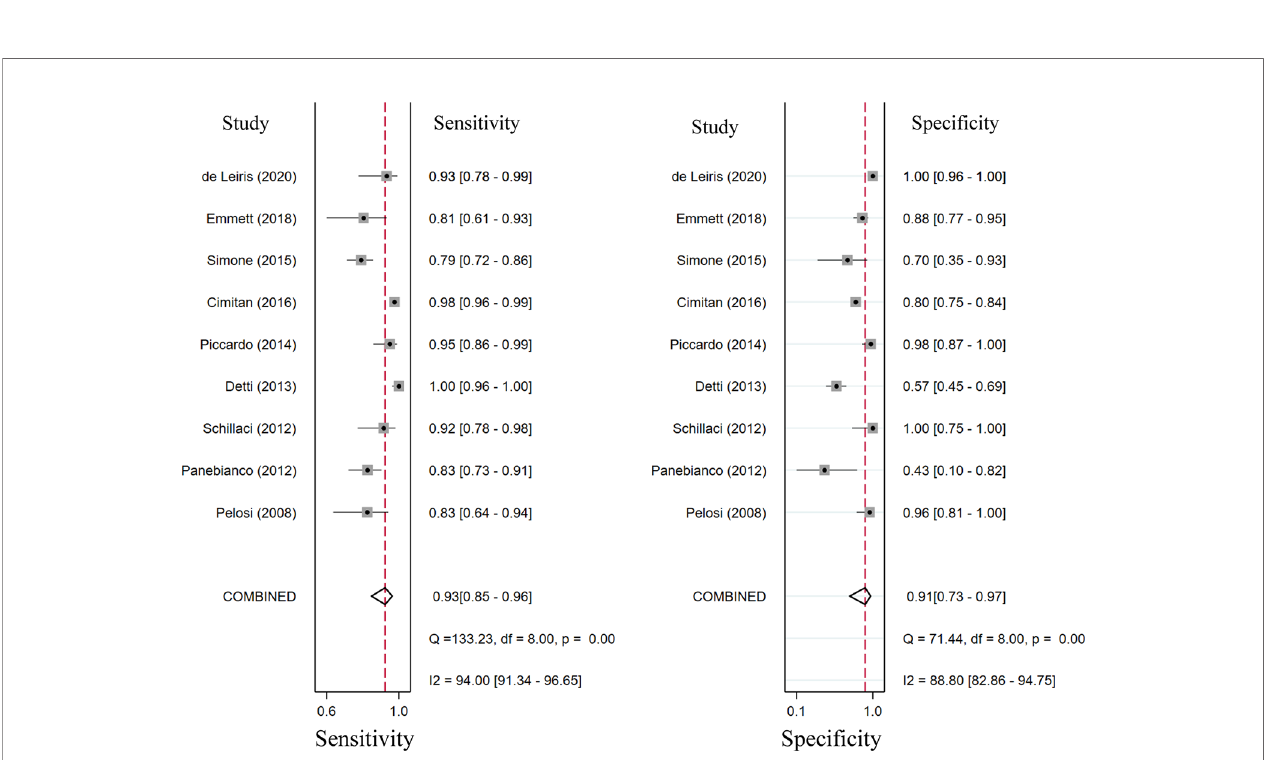
FIGURE 3 | Forest plot of the proportion of 18 F-choline positron emission tomography/computed tomography (PET/CT) sensitivity and speci fi city in prostate cancer patients with biochemical